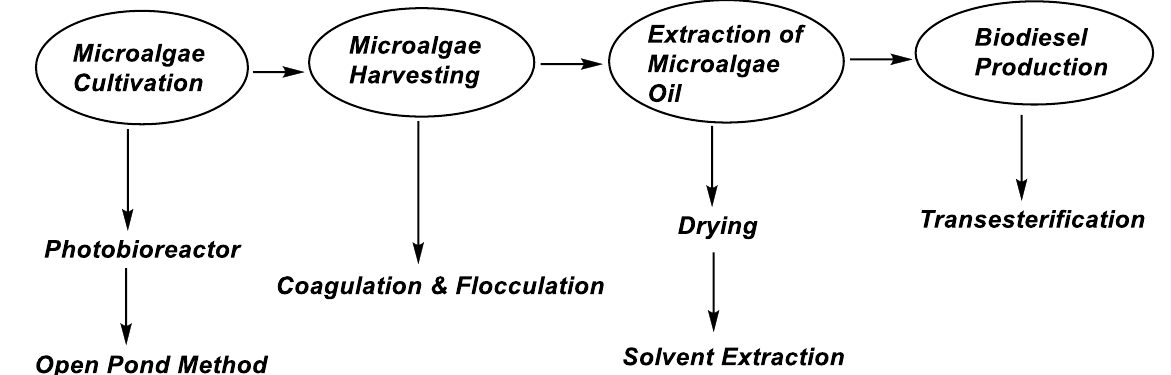
Figure 3. Description of biodiesel production from microalgae in developing countries.